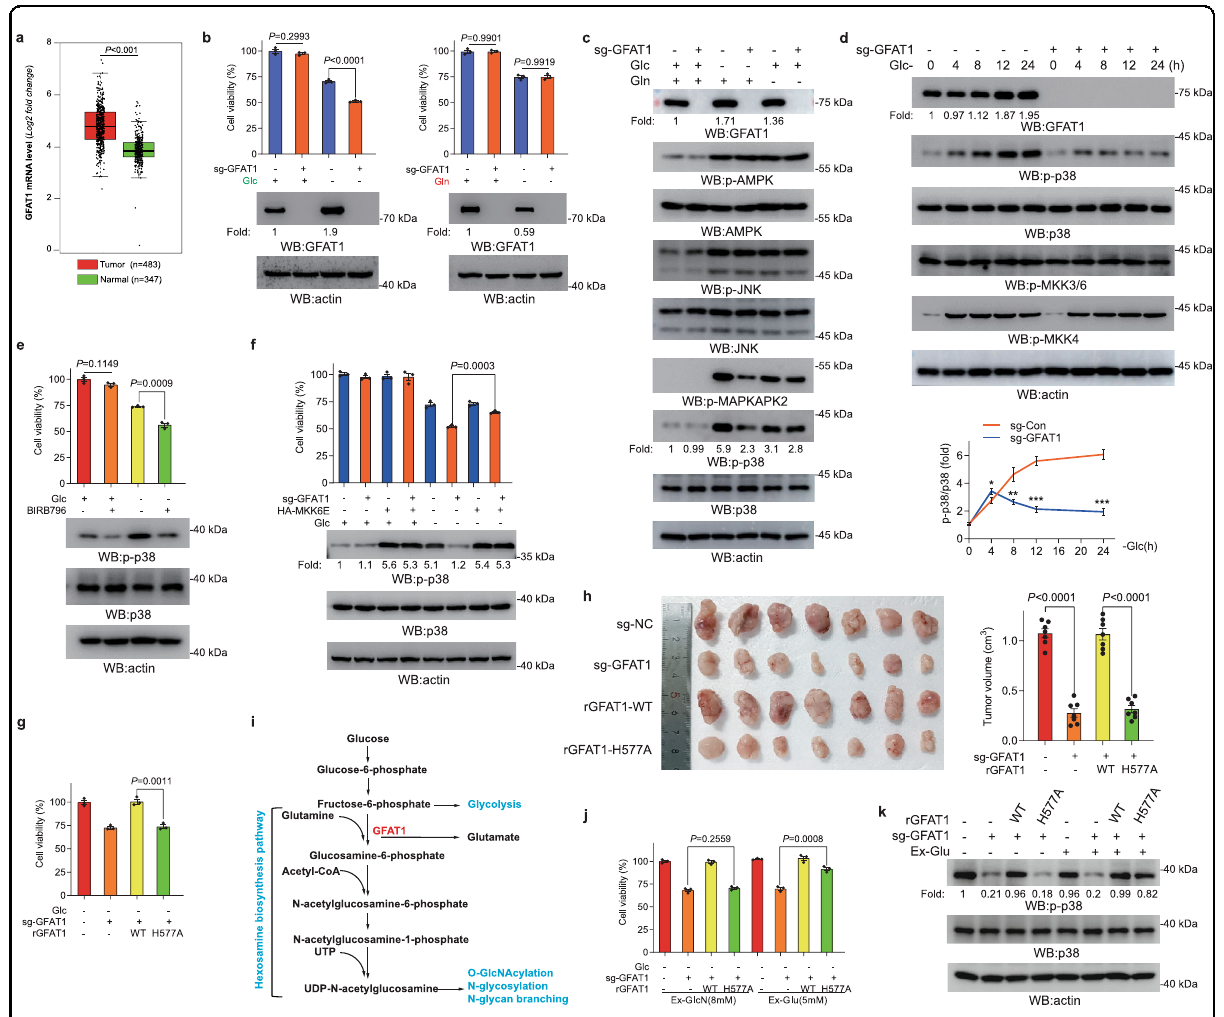
Fig. 1 GFAT1 activates p38 MAPK and promotes cell survival and tumorigenesis through its enzymatic activity. a The expression of GFAT1 in lung adenocarcinoma tissues based on GEPIA. b Glucose deprivation, but not glutamine deprivation, inhibited cell survival in GFAT1-deleted cells. A549 cells with or without deleted GFAT1 were cultured for 36 h under glucose or glutamine deprivation. Immunoblotting analyses were performed using the indicated antibodies. Cellular viability was examined by CCK8 assay. c GFAT1 deletion inhibited p38 activation. A549 cells with or without deleted GFAT1 were cultured for 12 h under glucose or glutamine deprivation. Immunoblotting analyses were performed using the indicated antibodies. d GFAT1 deletion inhibited p38 activation at late time points. A549 cells with or without deleted GFAT1 were cultured for indicated time under glucose deprivation. Immunoblotting analyses were performed using the indicated antibodies. e p38 suppression impaired cell survival. A549 cells were pretreated with or without BIRB796 (1 μ M) for 1 h before being cultured under glucose deprivation. Immunoblotting analyses were performed using the indicated antibodies. Cellular viability was examined by CCK8 assay at 36 h post glucose deprivation treatment. f Expression of MKK6E rescued cell survival in GFAT1-deleted cells. A549 cells with or without deleted GFAT1 and expression of HA-MKK6E were cultured under glucose deprivation. Cellular viability was examined by CCK8 assay at 36 h post glucose deprivation treatment. Immunoblotting analyses were performed using the indicated antibodies. g Expression of rGFAT1-H577A inhibited cell survival. A549 cells with or without deleted GFAT1 and reconstituted expression of WT rGFAT1 or rGFAT1-H577A were cultured under glucose deprivation. Cellular viability was examined by CCK8 assay at 36 h post glucose deprivation treatment. h GFAT1 deletion or expression of rGFAT1-H577A inhibited tumorigenesis. A total of 5 × 10 6 A549 cells with GFAT1 deletion and/or reconstituted expression of the WT rGFAT1 or rGFAT1-H577A were subcutaneously injected into athymic nude mice. Representative tumor xenografts are shown. Tumor volumes were measured by using length “ a ” and width “ b ” and calculated using the following equation: V = ab 2 /2. i A schematic diagram of the HBP. j Exogenous glutamate rescued cell survival in rGFAT1-H577A-expressing cells. A549 cells with or without deleted GFAT1 and reconstituted expression of WT rGFAT1 or rGFAT1-H577A were cultured under glucose deprivation and were added with indicated concentration of exogenous Glucosamine (Ex-GlcN) or glutamate (Ex-Glu). k Exogenous glutamate rescued p38 activation in rGFAT1- H577A-expressing cells. A549 cells with or without deleted GFAT1 and reconstituted expression of WT rGFAT1 or rGFAT1-H577A were cultured for 8 h under glucose deprivation and were added with 5 mM exogenous glutamate (Ex-Glu). Immunoblotting analyses were performed using the indicated antibodies. In a , b , d , e , h and j , the values are presented as means ± SEM, n = 3; P values (* P < 0.05, ** P < 0.01 *** P < 0.001, Student ’ s t -test, two-sided) with control or the indicated groups are